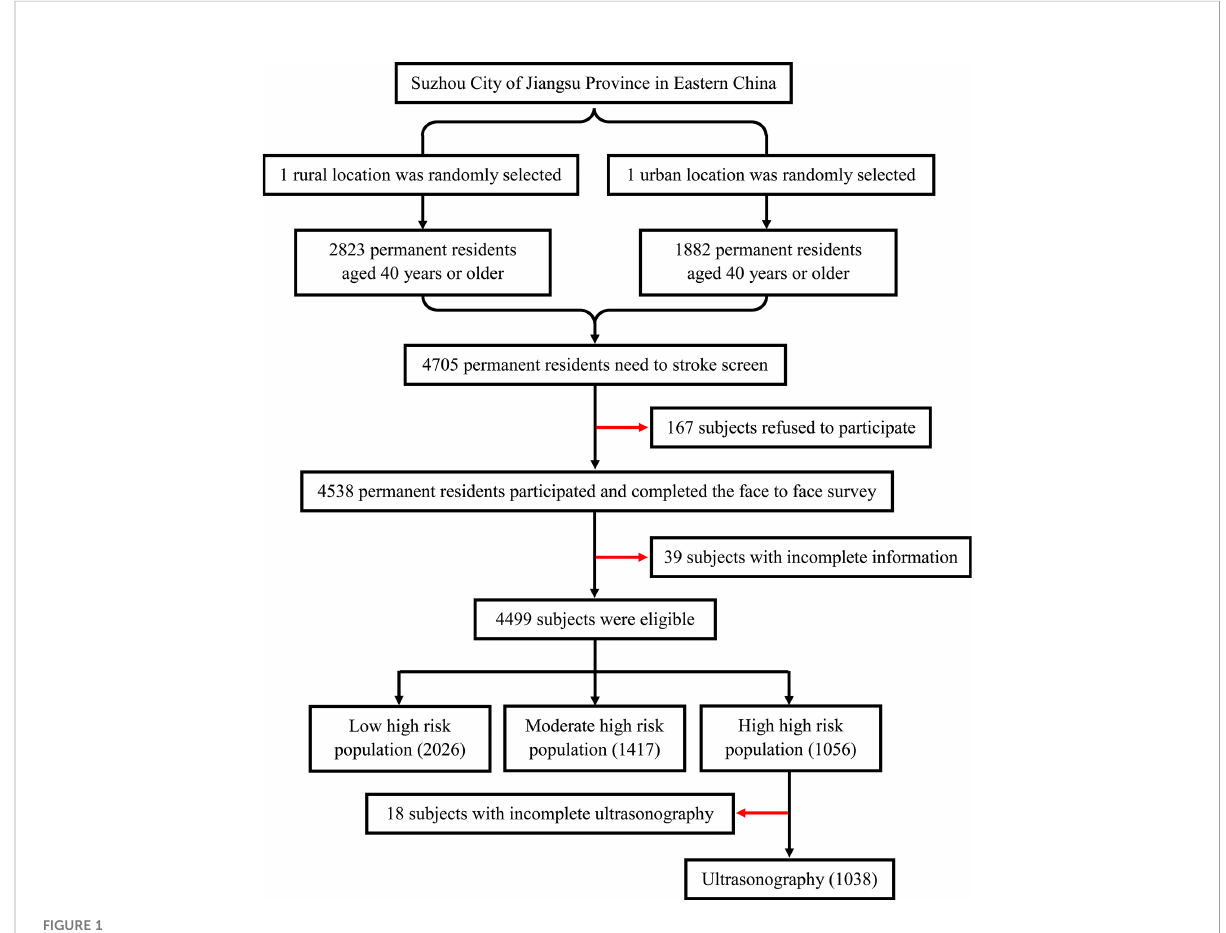
FIGURE 1 Flowchart of the enrollment of